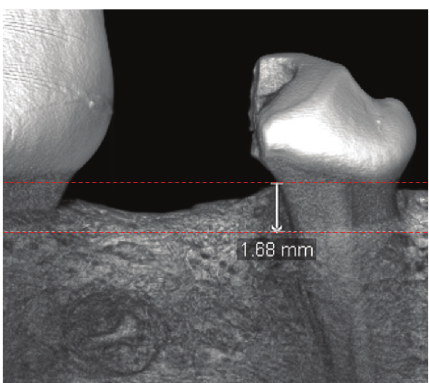
Figure 2: Measurement of vertical bone height (VBH) by micro- CT. The VBH was recorded as the linear distance from the enamel- cementum junction to the bottom of the bone